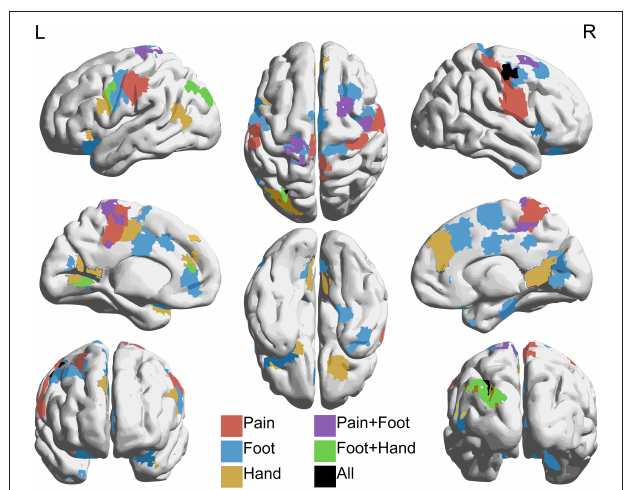
FIGURE 7 | Regions with increased connectivity to pain, foot, and hand association regions in NP subjects compared to controls. Regions within the 361 combined parcellation showing increased connectivity ( p < 0.05 uncorrected) with individually defined regions associated with pain, foot, and hand in NP subjects when compared to controls. Hyperconnectivity was seen between the pain region and parts of the dorsal attention, ventral attention, and somatomotor networks. The foot region showed increased connectivity with parts of the cingulo-opercular, dorsal attention, fronto-parietal, and somatomotor networks. The hand region showed increased connectivity with default, dorsal attention, fronto-parietal, ventral attention, and somatomotor networks. Lateral (top left and right), medial (middle left and right), anterior (bottom left), posterior (bottom right), superior (top middle), and inferior (bottom middle) views are